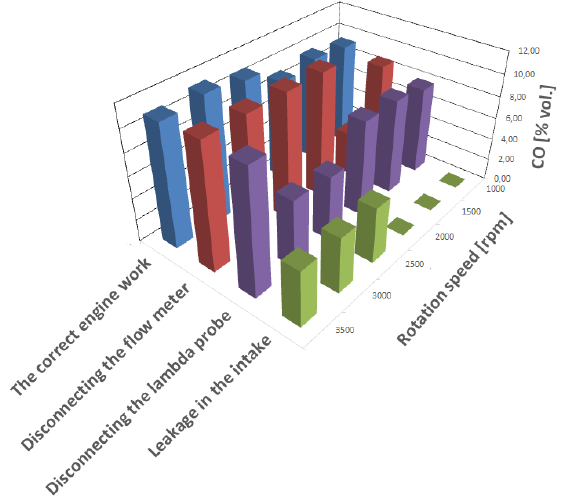
Fig. 5. The content of carbon monoxide in the exhaust gas of a BMW engine fueled with LPG working efficiently and for simulated damage